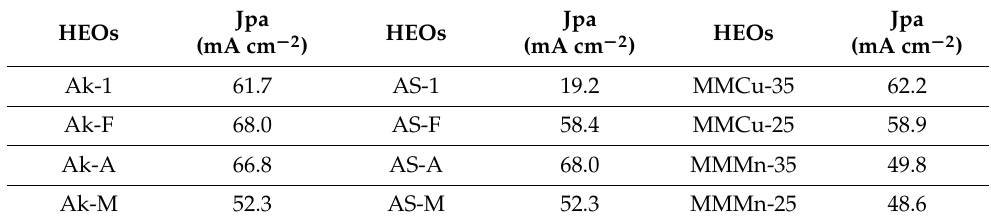
Table 3. The geometrically normalized peak current values for WOR using all the HEOs at 100 mV s − 1 in 1M KOH + 1M CH 3 OH.